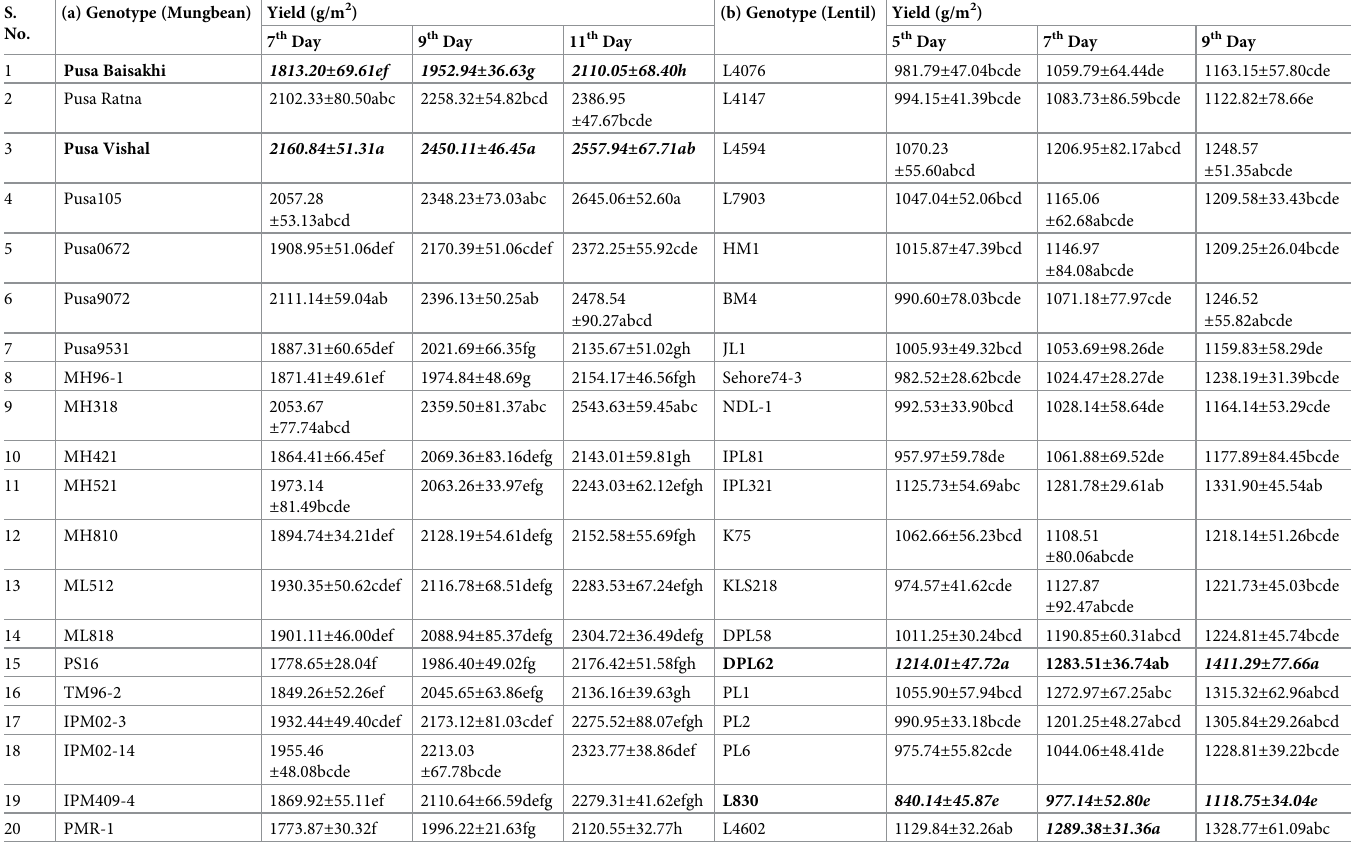
Table 3. Microgreens yield (g/m 2 ) of twenty lentil and mungbean genotypes at different days of harvesting. S. No.